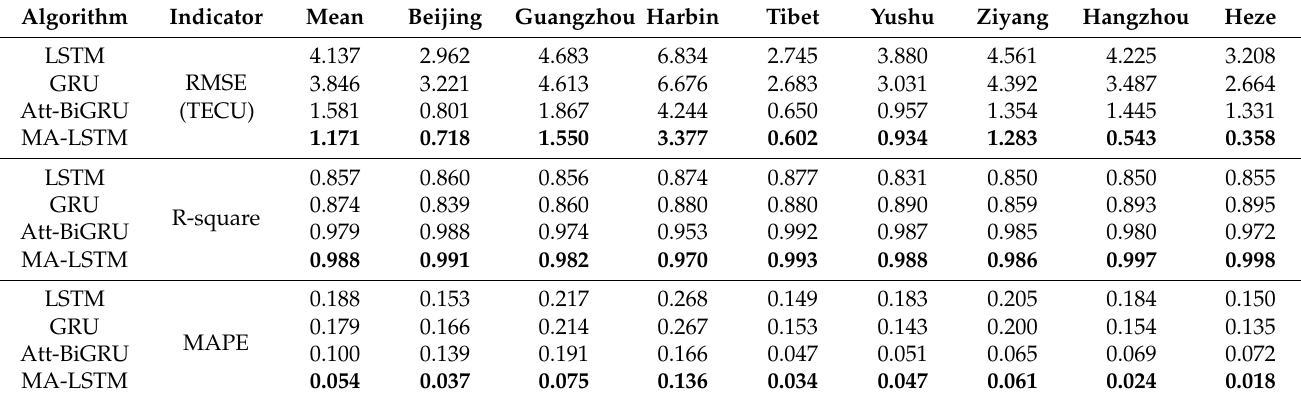
Table 3. Comparison of prediction performance of different